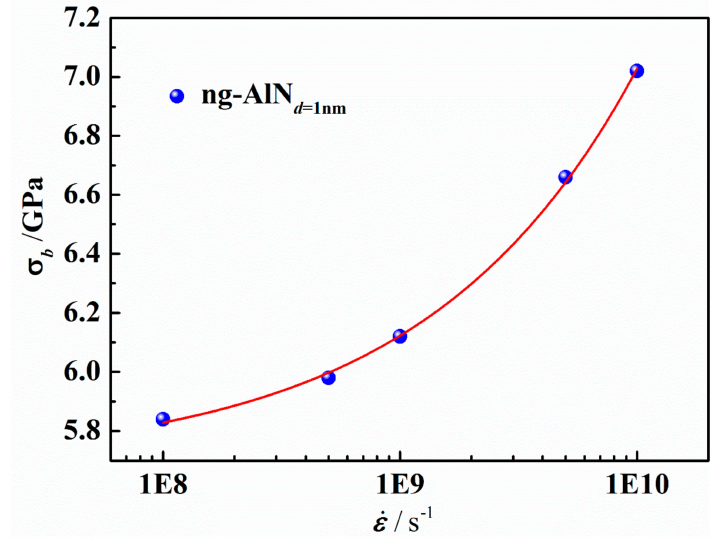
. ε ) for ng-AlN d = 1